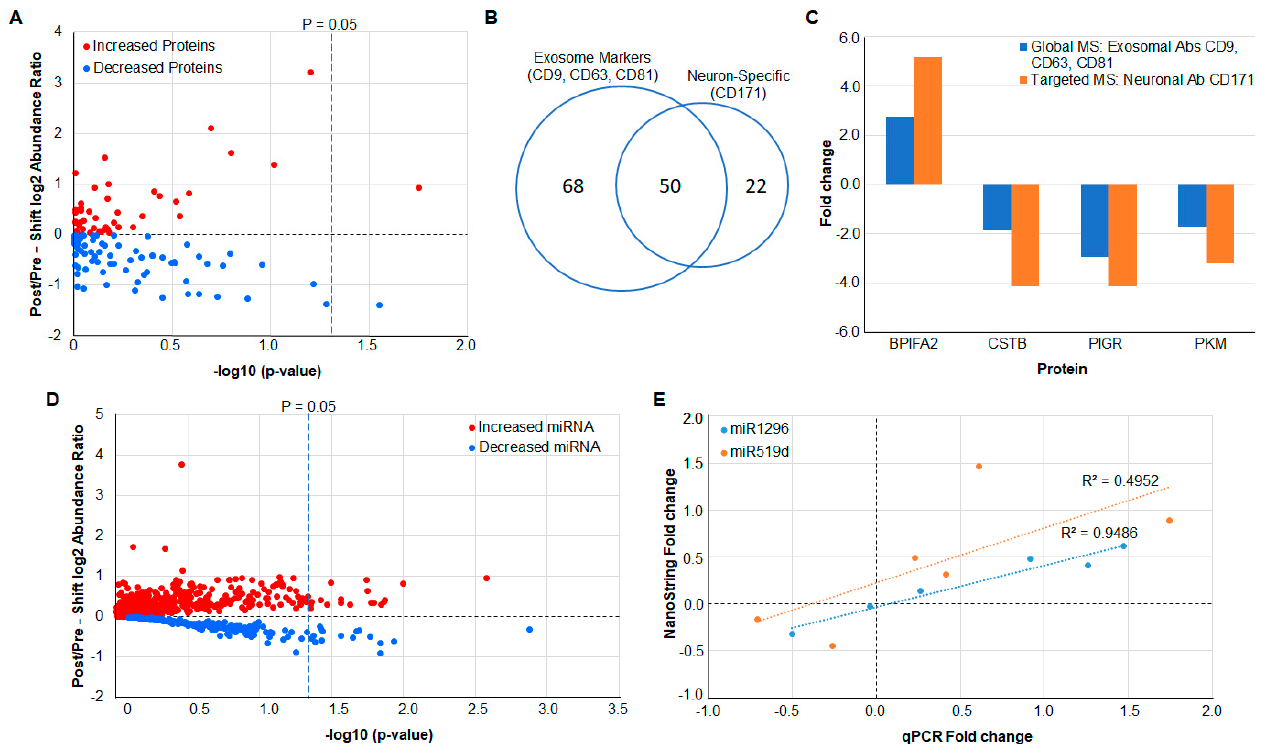
Figure 2. Multiomics analysis reveals quantifiable differences in protein and miRNA abundances in the Test group pan- and neuron-derived exosomes. ( A ) Differences in the abundances of pro- teins present in the salivary exosomes of Test group participants pre- and post-work shifts are illustrated via a volcano plot. The log 10 (abundance ratio: post-work/pre-work) is plotted against − log 10 ( p value). ( B ) A Venn diagram shows the overlap of proteins found in exosomes isolated with pan-exosomal or neuron-selective exosomal markers for a single participant. ( C ) The protein fold change for the single Test group participant is shown when using global proteomics on exo- somes isolated by a pan-exosome set of antibodies (Global MS (exosome abs: CD9, CD63, CD81); blue bars) or targeted MS on four corresponding to the four proteins (STVSSLLQK/BPIFA2, SQVVAGTNYFIK/CSTB, TVTINCPFK/PIGR, LDIDSPPITAR/PKM) present in exosomes isolated using an antibody to a neuron-specific exosome marker (Targeted MS (neuronal ab: CD171); or- ange bars). ( D ) Differences in the abundances of miRNAs present in the salivary exosomes of par- ticipants pre- and post-work shift are illustrated via a volcano plot. The log 10 (abundance ratio: post-work/pre-work) is plo tt ed against − log 10 ( p -value). ( E ) Fold change of miR-519d and miR-1296 as measured using the NanoString platform ( y -axis) shows a moderate and strong positive correla- tion (miR-519d R 2 = 0.50, r (5) = 0.70, p = 0.01881; miR-1296 R 2 = 0.95, r (5) = 0.97, p = 0.0062) with fold change as measured by qPCR ( x -axis). 3.2. Verification of Protein Measurements in Neuron-Derived Exosomes by Targeted MS In the single Test group of participants from which neuron-derived exosomes were isolated, as many as 50 of the proteins identified from the immunoprecipitation using ex- osomal cell surface markers CD9, CD63, CD81 (Supplementary Table S2) were subse- quently also identified using targeted MS for neuron-derived exosomes after isolation of salivary exosomes using neuron cell surface marker (CD171) (Figure 2B and Supplemen- tary Table S4 ) . The targeted MS was performed for proteins with abundant peptides that contained no post-translational modifications. Four proteins—BPIFA2, CSTB, PIGR, and PKM—in neuron-derived exosomes correlated well with global proteomics used for exo- somes isolated using pan-exosomal markers, but the protein fold change observed in the targeted MS was higher compared with global proteomics (Figure 2C ) .